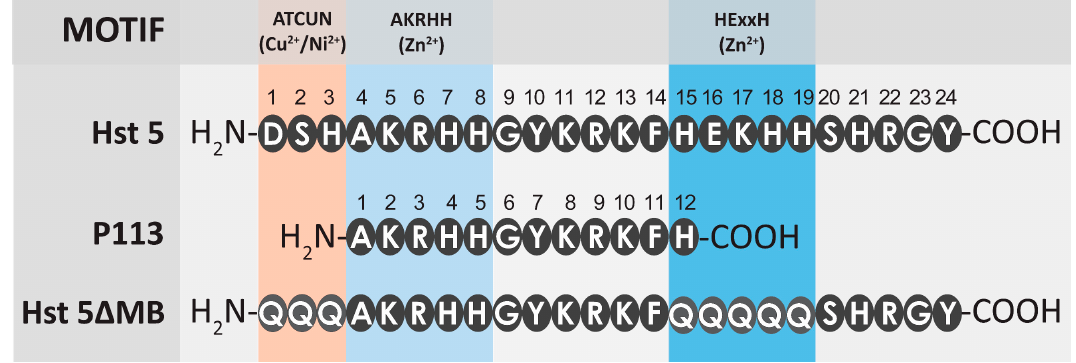
Figure 1. A comparison of the length and metal binding regions of amino acid sequences for Hst 5, Hst 5 Δ MB, and P113. Three metal binding motifs are labeled—ATCUN (Cu 2+ , orange), HExxH (Zn 2+ , blue), and (H)AKRHH (Zn 2 + , light blue). P113 is truncated to amino acids 4-15 of Hst 5. The ATCUN (AA 1-3) and HExxH (AA 15-19) motifs of Hst 5 Δ MB are mutated to glutamines.